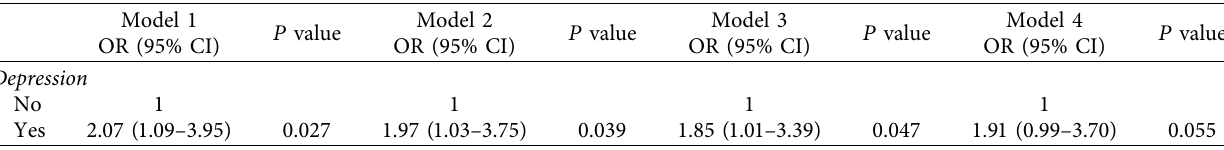
Table 4: Adjusted models for association of depression with uncontrolled hypertension excluded “without treatment” ( N �